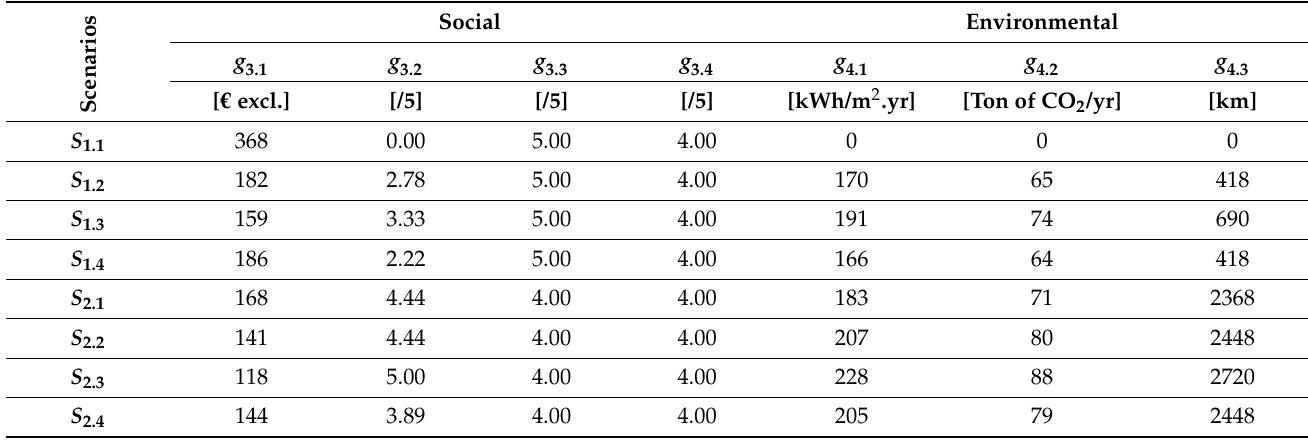
Table 11. Performance matrix for global retrofit scenarios—(part